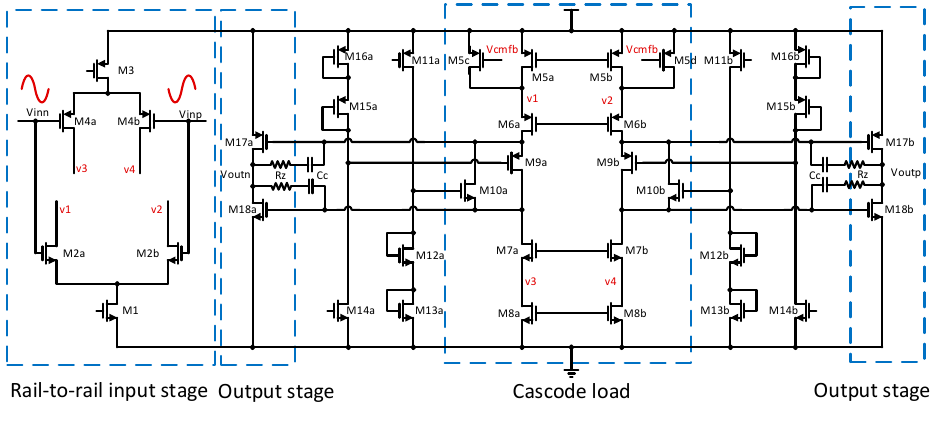
Figure 7. The structure of the OPA. Table 1 lists the main performance of the designed OPA by the simulation results. Table 1. Performance summary of the OPA.